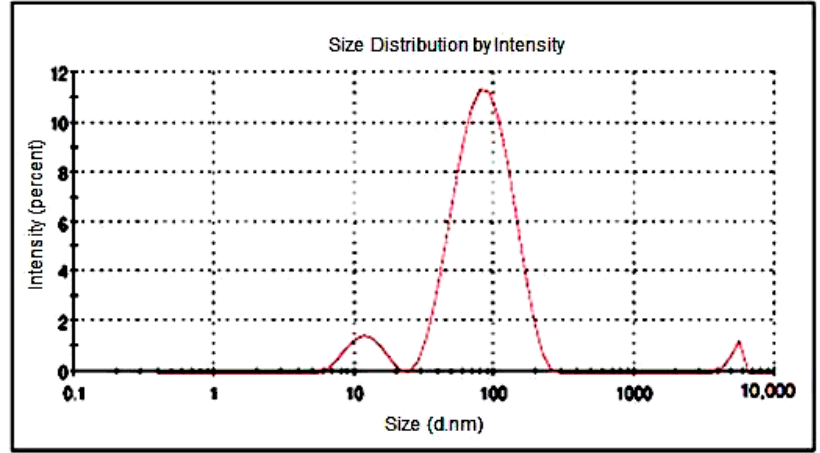
Figure 7. Dynamic light scatter of GAg nanocomposite.